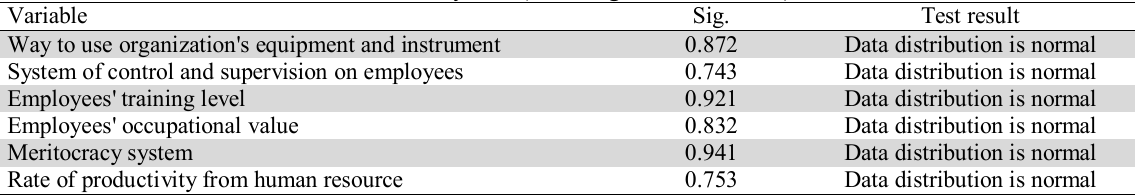
Data distribution is normal